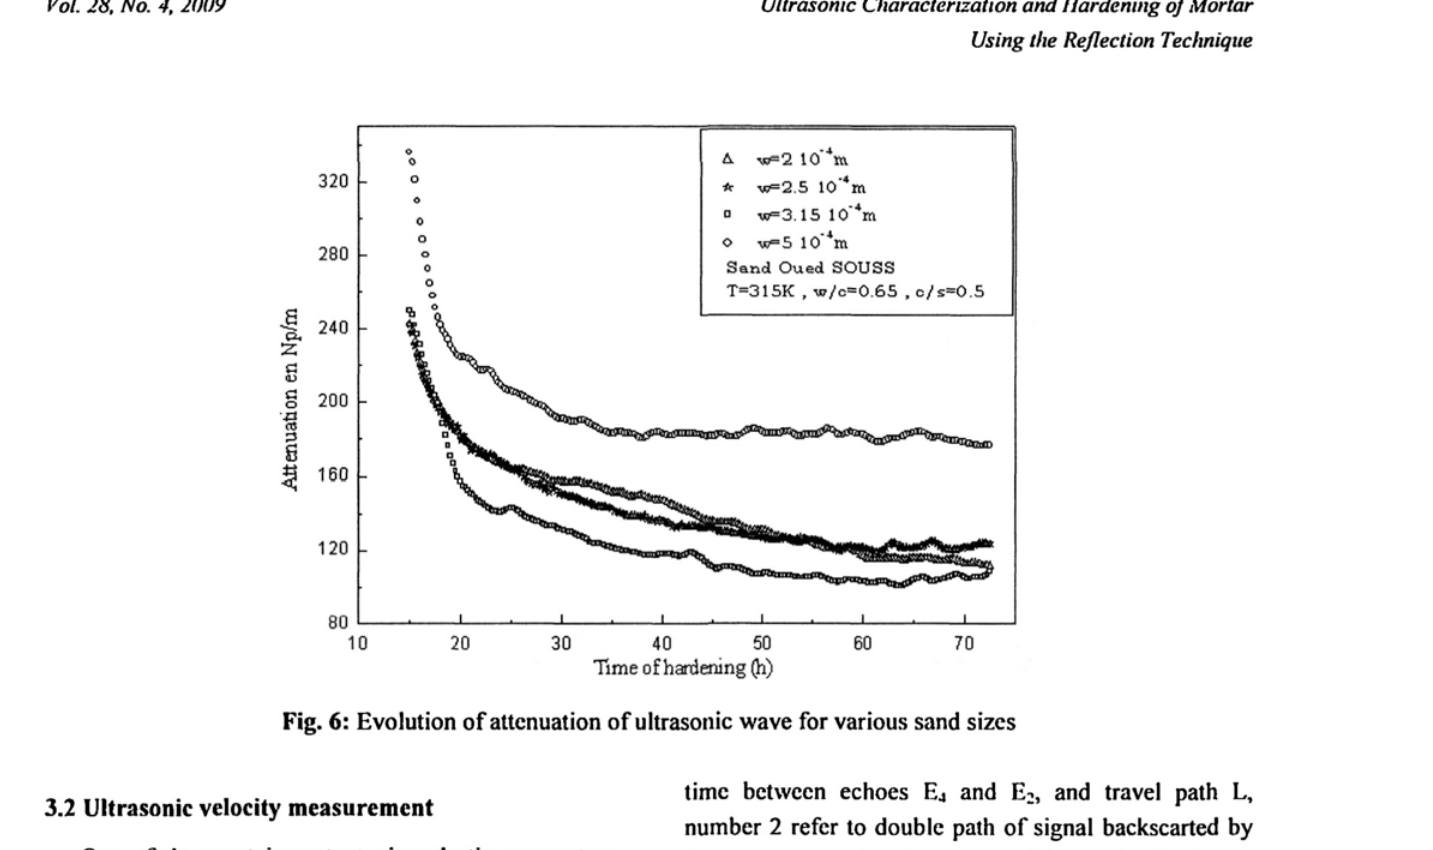
Fig. 6: Evolution of attenuation of ultrasonic wave for various sand sizes